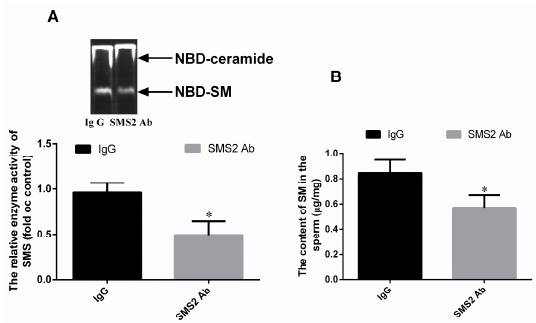
Figure 3. The enzyme activity of SMS and SM content. ( A ) The enzyme activity of SMS; ( B ) the SM content in sperm. Values shown are the mean ± SD ( n = 3), * p < 0.05 vs. IgG group.